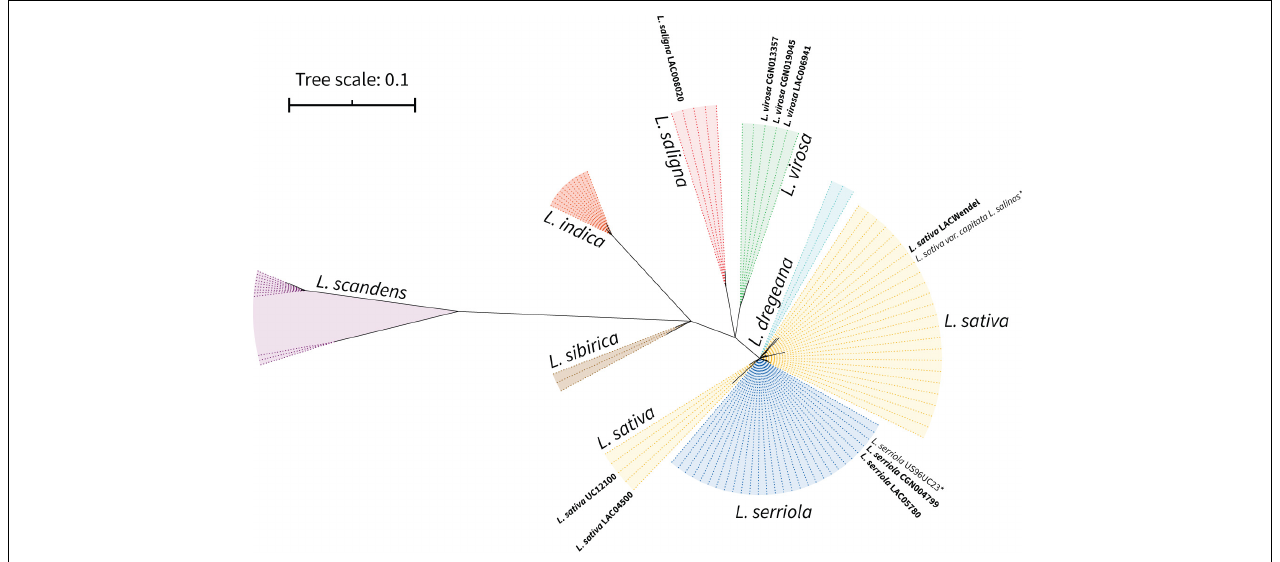
FIGURE 2 | Phylogenetic relation of the selected Lactuca accessions according to nuclear marker ( ITS1-rRNA5.8S-ITS2 ). Maximum likelihood phylogram of the sequences of internal transcribed spacers 1 and 2 and the 5.8S rRNA. Bootstrap values are not shown but branches with BS < 99 are collapsed. *Sequences assembled from Kozik et al. (2019) raw reads SRX5097892 ( L. serriola US96UC23) and SRR577192 ( L. sativa cv. Salinas